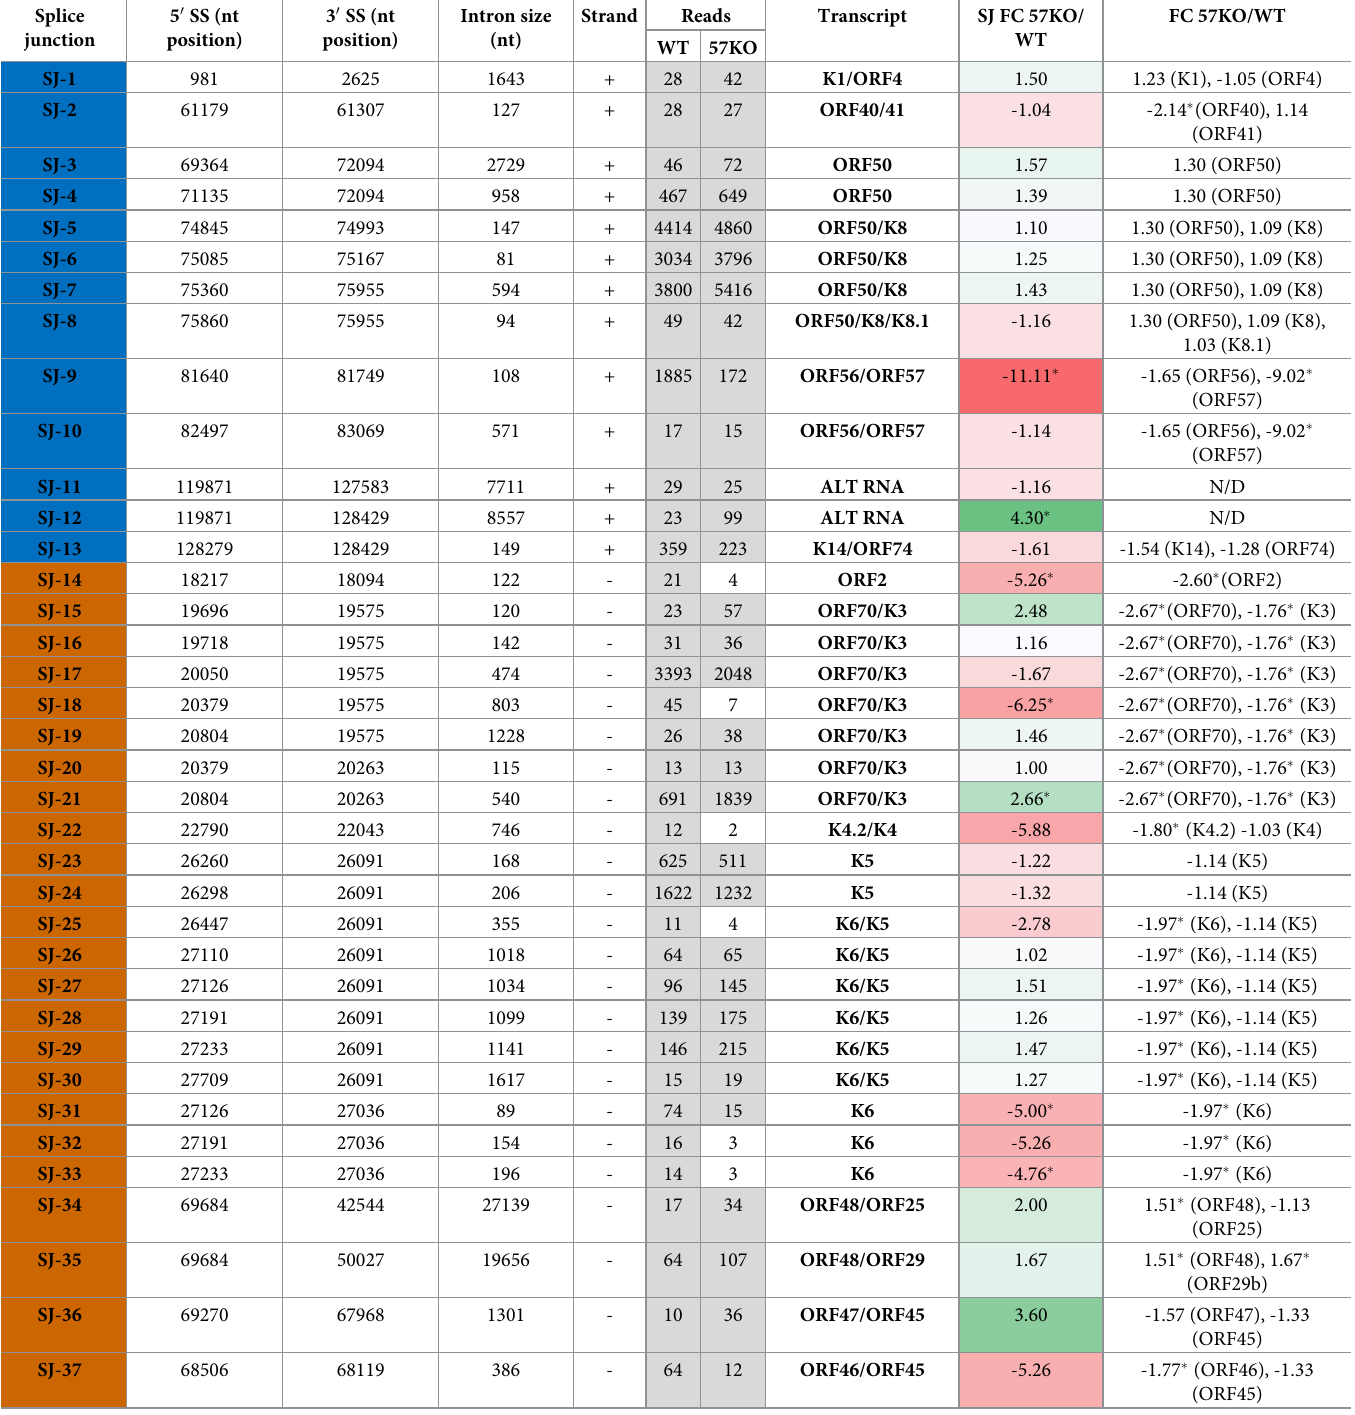
Table 1. Identified RNA splice junctions (SJ) with � 10 splice reads from the KSHV WT or 57KO genome in BCBL-1 cells. The positions of 5 0 and 3 0 splice sites (SS) are based on the KSHV reference genome GenBank Acc. No. HQ404500. The reads-number represents a total number of splice reads in the WT or 57KO group during lytic replication (see S2 Table for the details). The SJ fold change (FC) represents splice junction-reads change in BCBL-1 cells with the KSHV 57KO versus WT genome during viral lytic replication. The asterisk marks significant (p � 0.05) change by Student t -test. The transcript FC for the annotated genes was determined by Limma Voom differential gene expression analysis (see S1 Table for the details), with the color gradient red for decrease and green for increase. The genes with significant expres- sion changes (p � 0.01) are marked with an asterisk. N/D—not